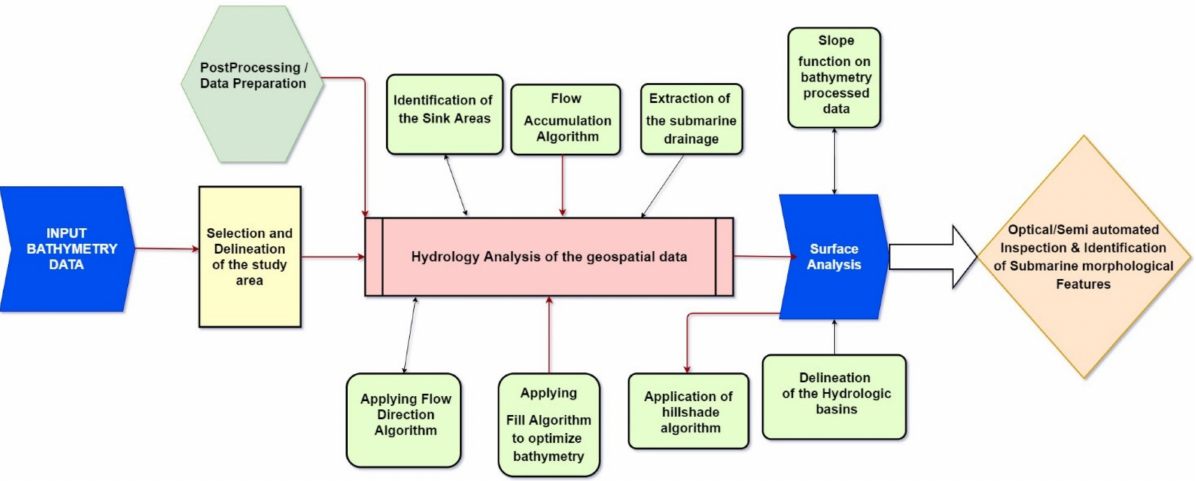
Figure 2. Workflow of the data preparation for hydrologic and surface analysis using initial processed bathymetric